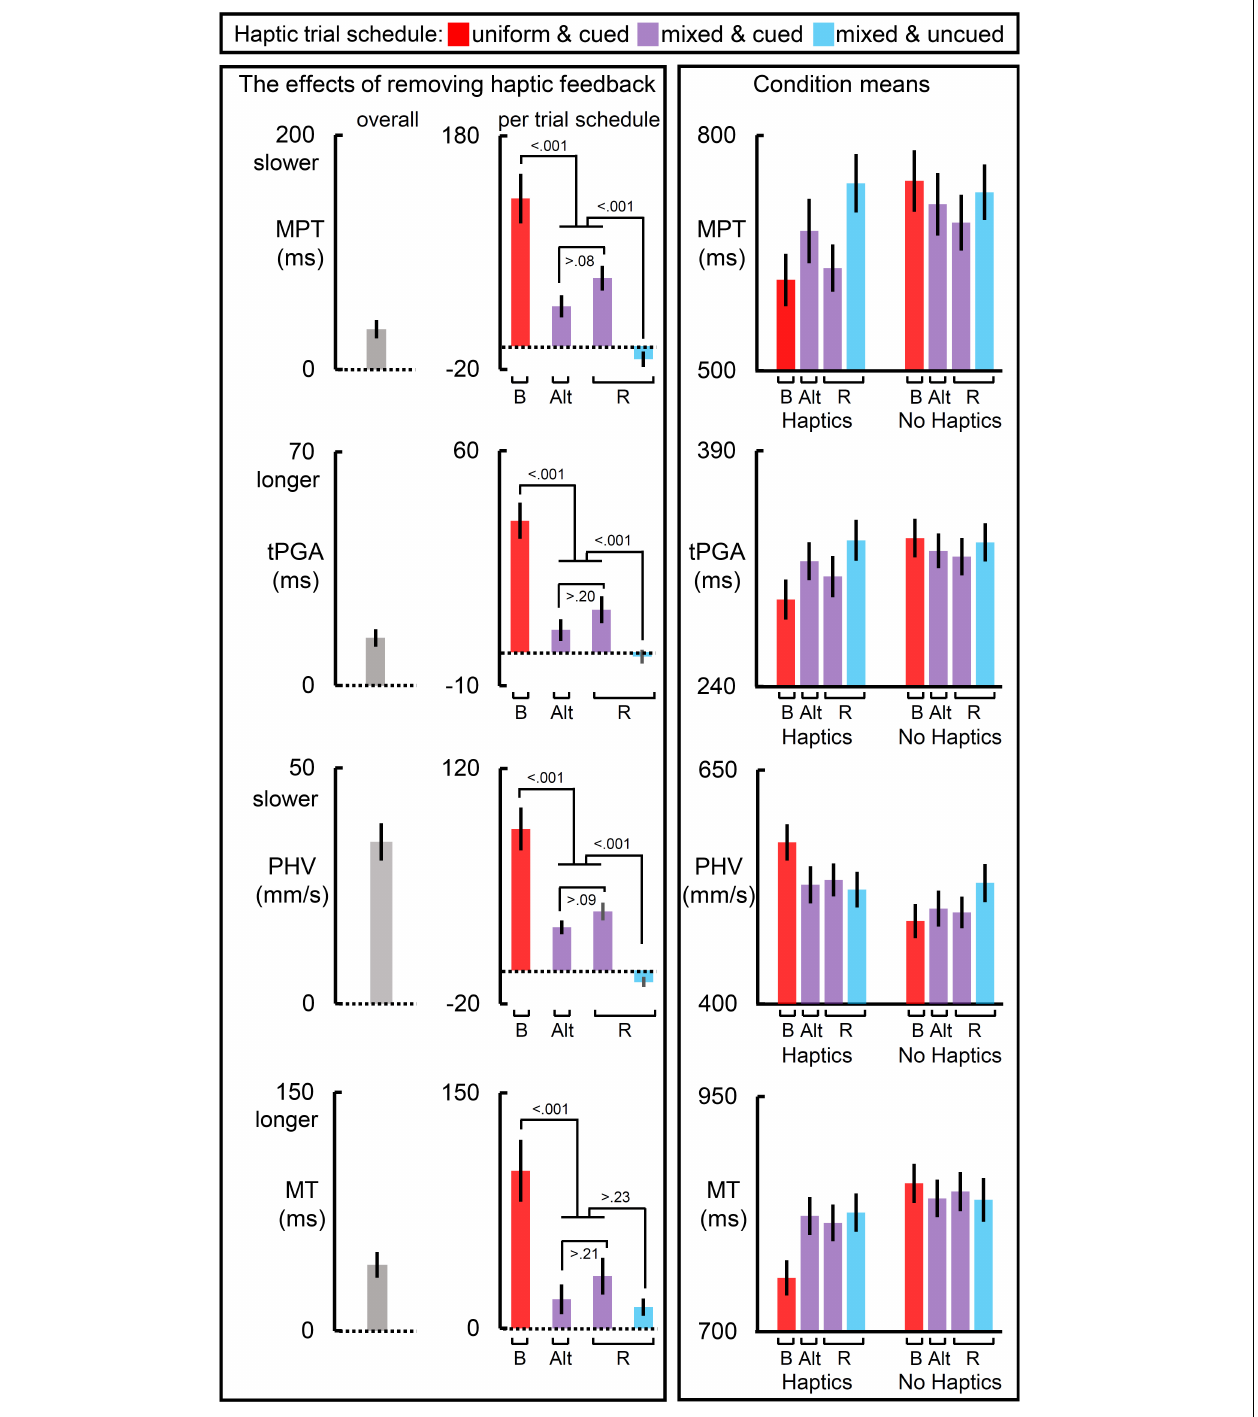
FIGURE 2 | The effects of removing haptic feedback on temporal and transport measures. The leftmost and middle columns of panels reflect the effect of removing haptic feedback on movement preparation time (MPT), time to achieve peak grip aperture (tPGA), peak hand velocity (PHV), and the movement time (MT). Removing haptic feedback slowed MPT, PHV, and MT, and prolonged tPGA. Most notably, the schedule of haptic feedback modulated these effects (middle column of panels). On each of these measures, the blocked scheduled (red bars) yielded the largest effect, the cued mixed schedules yielded an intermediate one, and the uncued randomized schedule yielded the weakest effect (with the exception of MT). The raw condition means for each measure are depicted in the rightmost column of panels. Bar label “B” refers to the blocked trial order; “Alt.” alternating block of trials; and “R” randomized ones. Dotted lines reflect null of removing haptic feedback. All error bars reflect SEMs, and the dotted lines reflect the null hypothesis for tests against